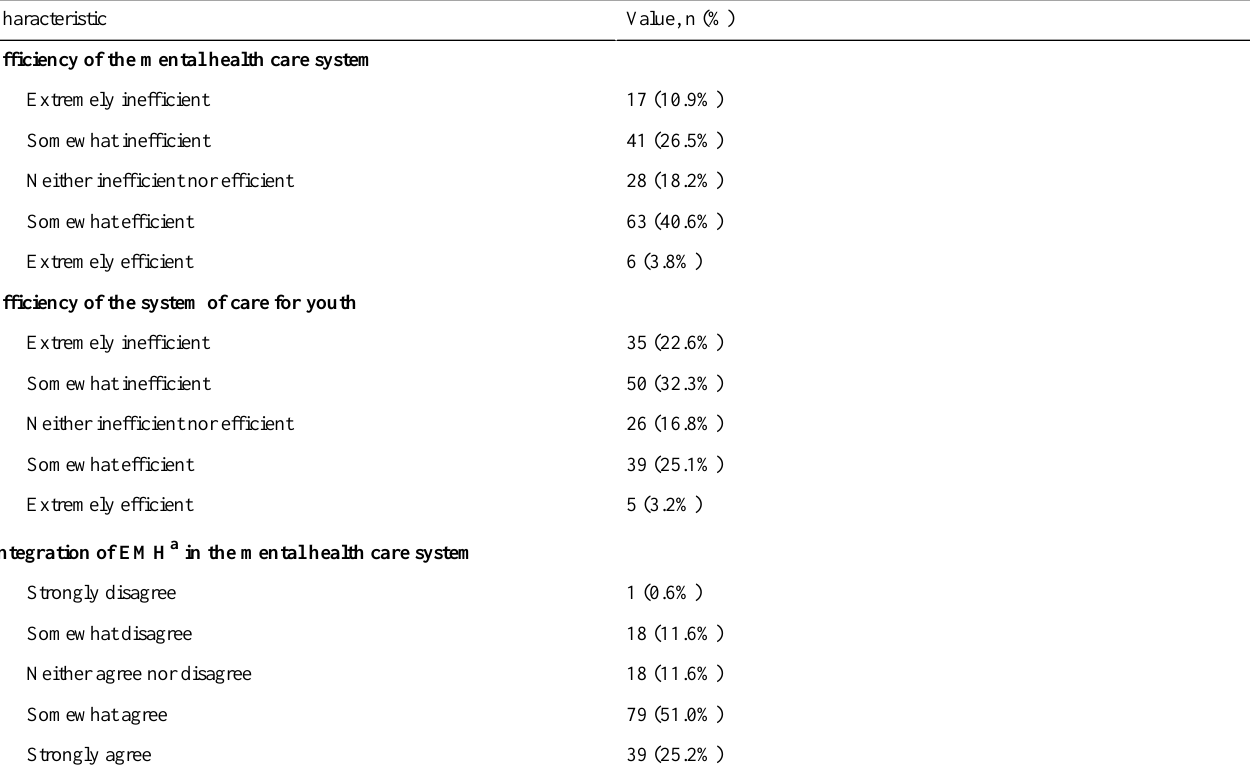
Table 2. Efficiency of the current system and integration of electronic mental health